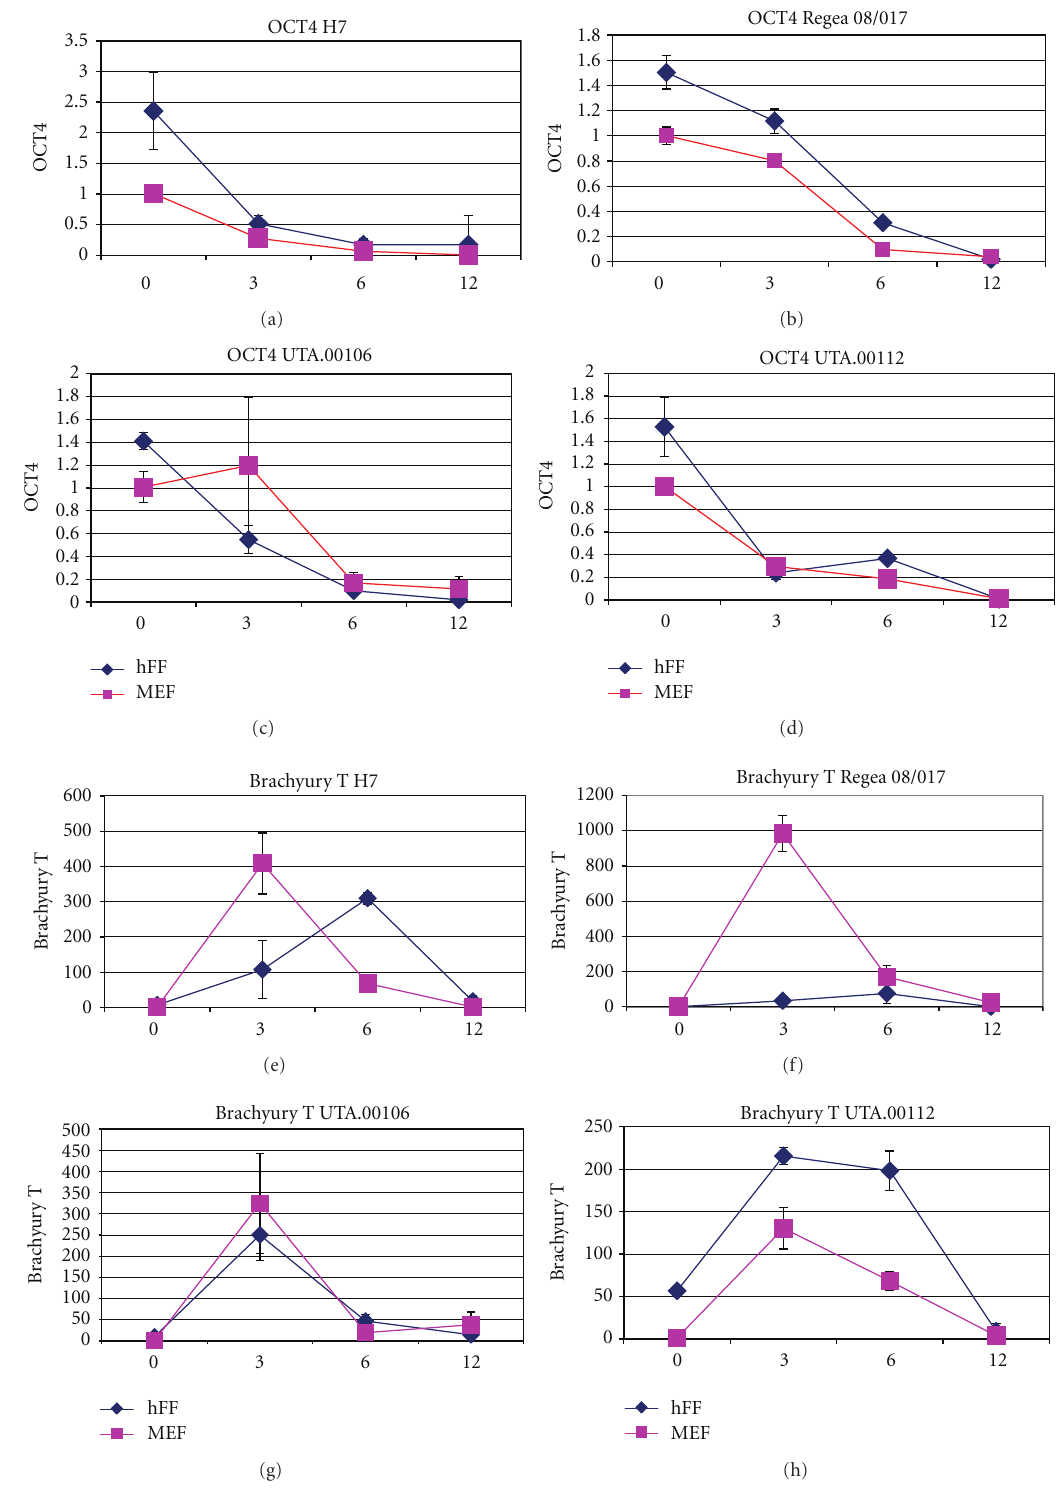
Figure 3: Oct4 (a–d) and Brachyury T (e–h) expression levels of H7, Regea 08/017, UTA.00106, and UTA.00112 cell lines on MEF and hFF feeder